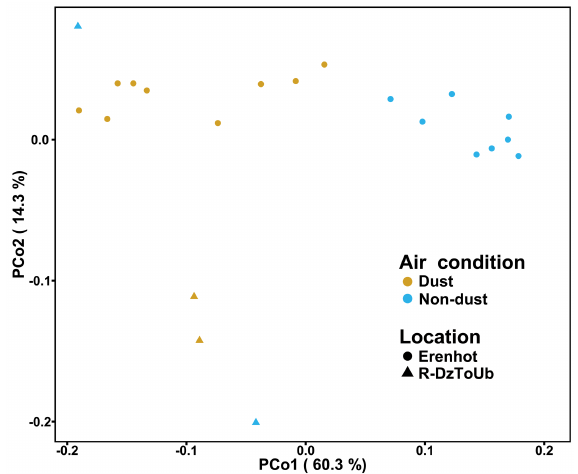
Figure 13. Principal coordinate analysis of bacterial 16S rRNA se- quencing data obtained from 22 samples (PCo: principal coordi-